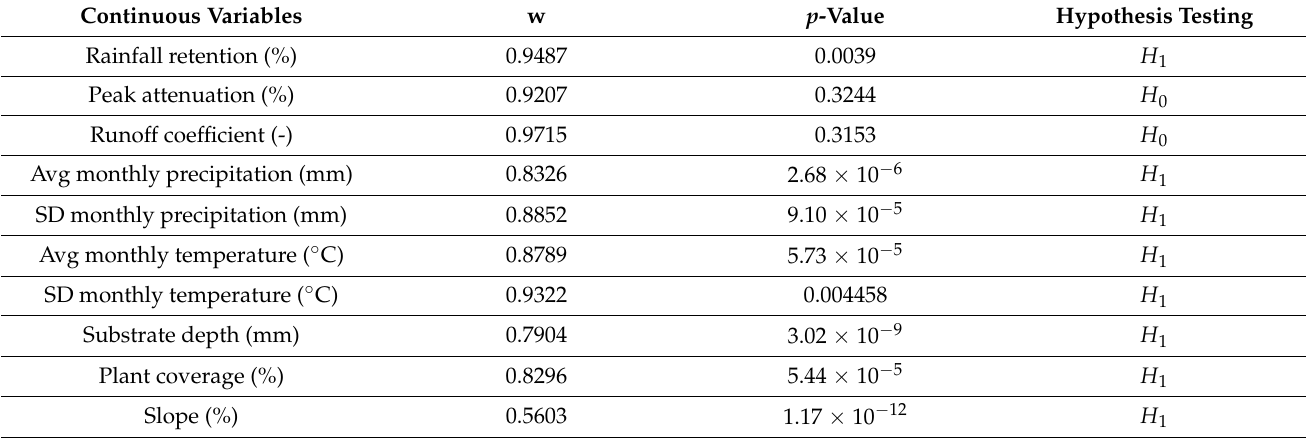
Table A7. Variables considered for the multivariate analysis.